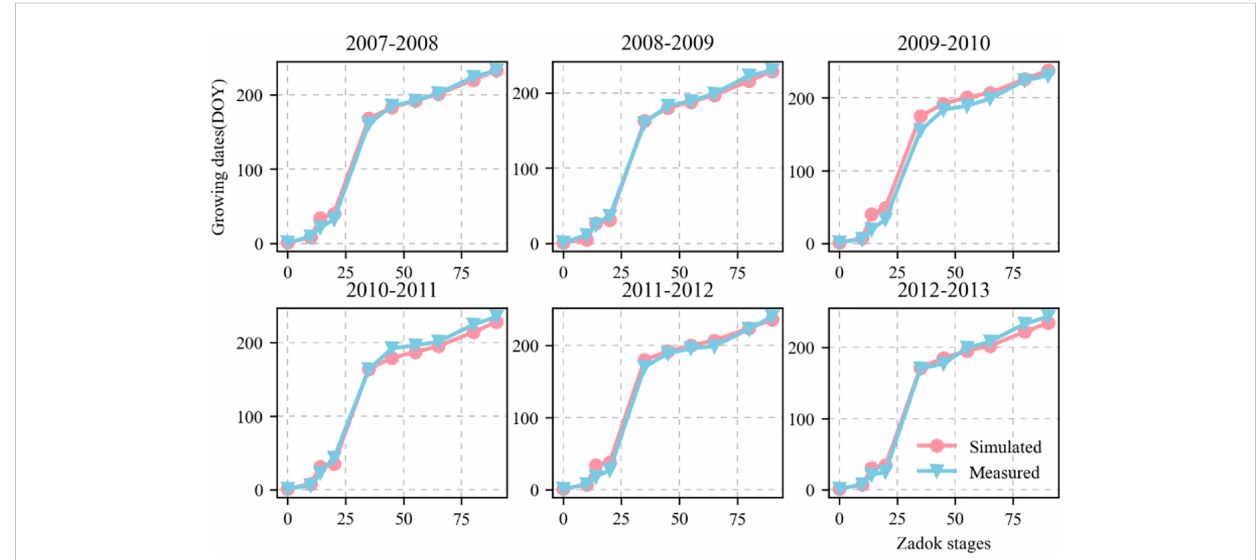
FIGURE 4 Comparison between measured and simulated values of wheat growth stages (Zadoks growth stage) including emergence (Z10), three leaves (Z14), tillering (Z20), elongation (Z35), booting (Z45), heading (Z55), anthesis (Z65), medium milk (Z80), and maturity (Z100). Red circles and blue triangles represent simulated and measured values, respectively. Zadoks growth stage is sourced from Zadoks et al. (1974).